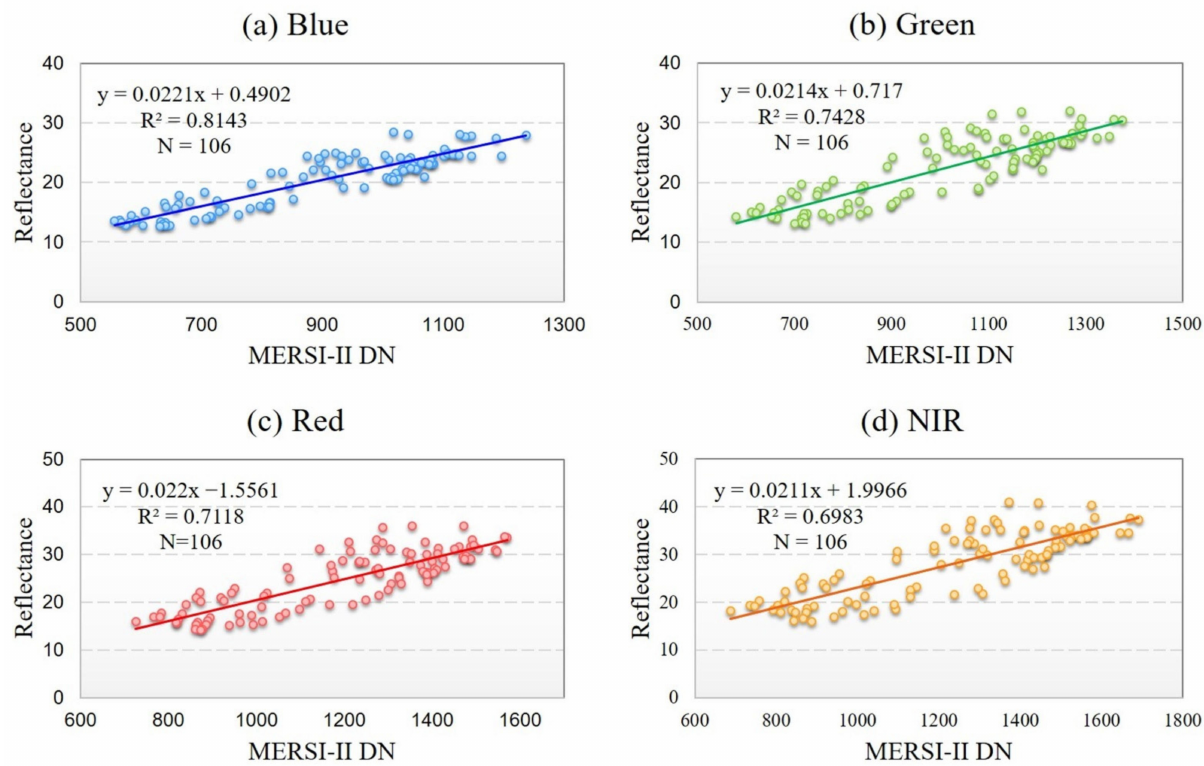
Figure 6. The relationships between in-situ measurements simulated at-sensor reflectance and Digital Numbers (DNs) of FY-3D MERSI-II for the four spectral bands using the normal reflectance-based method without BRDF correction: ( a ) blue band; ( b ) green band; ( c ) red band; ( d ) Near-infrared (NIR) band. Least-squares linear fitting resulted in vicarious calibration